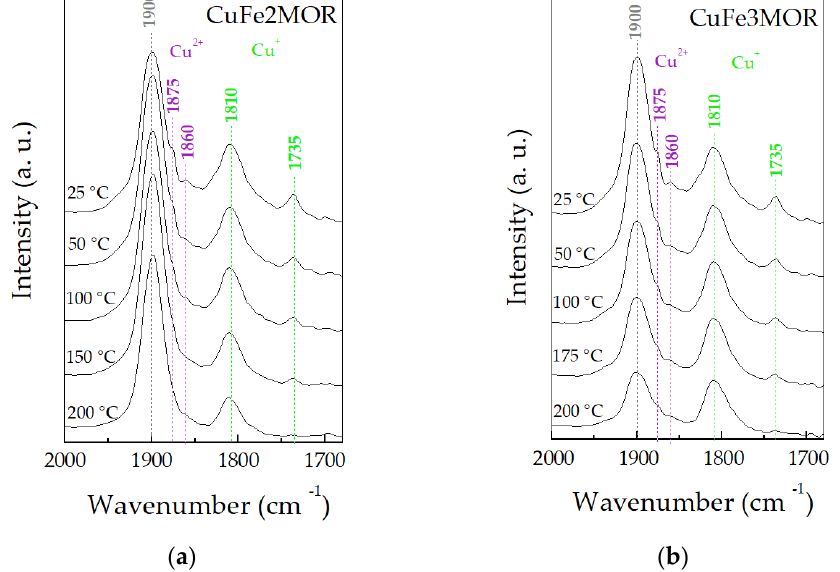
Figure 8. DRIFT spectra of adsorbed NO for CuFe2MOR ( a ) and CuFe3MOR ( b ).